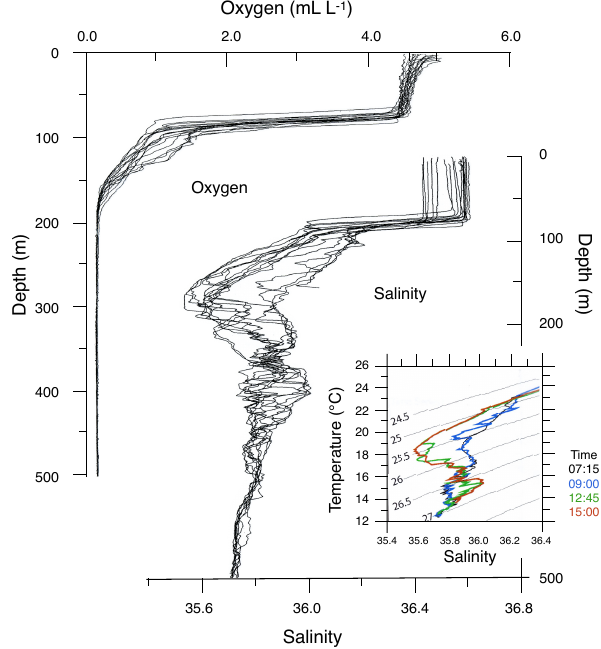
Fig. 2. Sta. 4010 of R/V Sagar Sampada near 19 ◦ N, 67 ◦ E (circle in Fig. 1) in January 1998. (a) Salinity and (b) O 2 records from the CTD casts taken over 25h, most of them hourly until 16:45LT. The ship drifted by about 41km between the first and last casts; (c) T – S diagram for four of the casts during the first 8h (drift, about